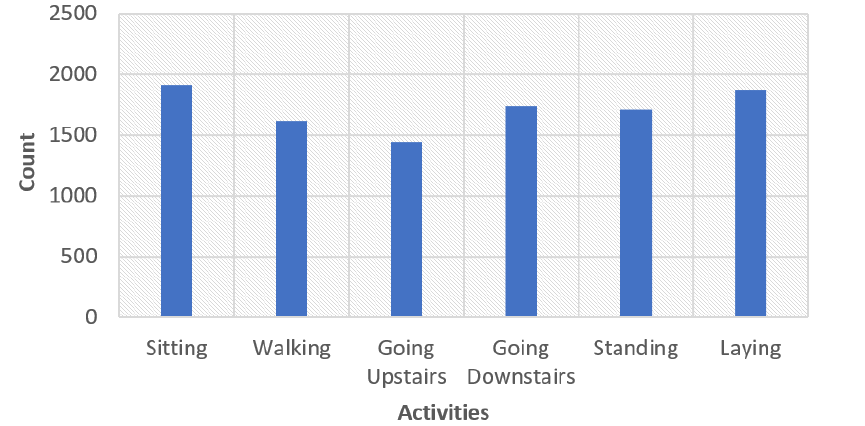
Figure 2. Representation of the distribution of activities such as standing, sitting, laying, walking, going upstairs, and going downstairs with respect to the total data of 10,299 samples. From the data, it can be seen that the most-performed activity is sitting, and the least is going